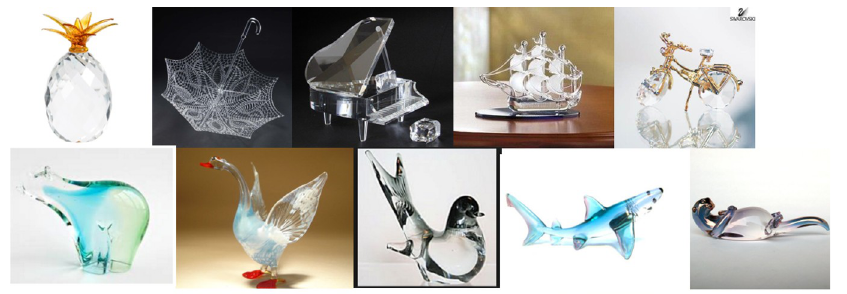
Fig 9. Sample stimuli used in Experiment